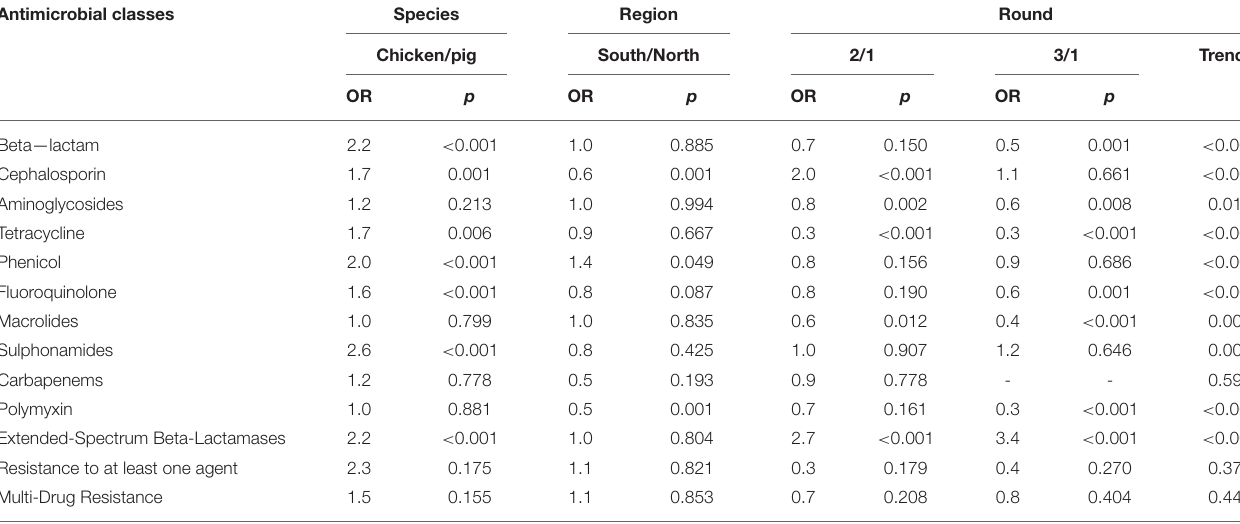
TABLE 2 | Association between Escherichia coli resistance, species, region and round, Vietnam, 2017–2019. Antimicrobial classes Species Region Round Chicken/pig South/North Trend p